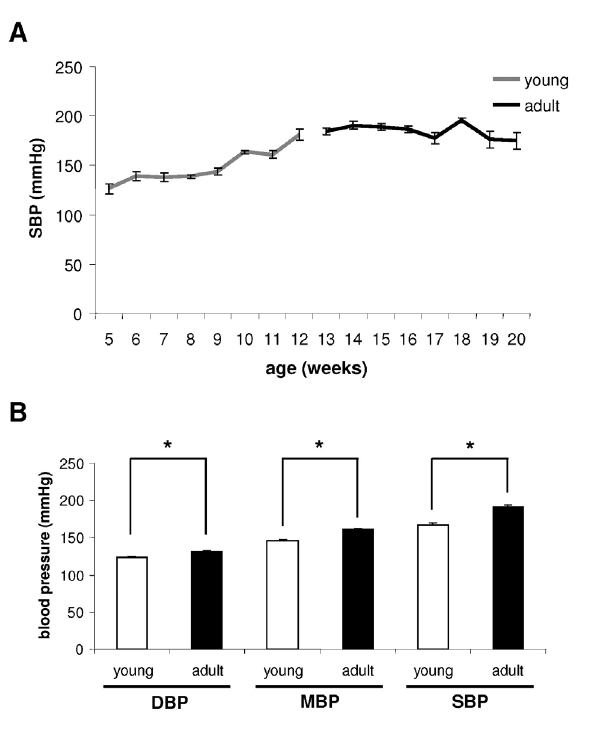
Figure 1 - Indirect and direct blood pressure (BP) measurements. A: tail systolic blood pressure in young and adult rats during experiment. Observe the BP stabilization between the 10 th and 12 th weeks of age. B: direct systolic BP (SBP), mean BP (MBP) and diastolic BP (DBP) in young and adult rats. Observe that adult rats presented increases in BP. * p ≤